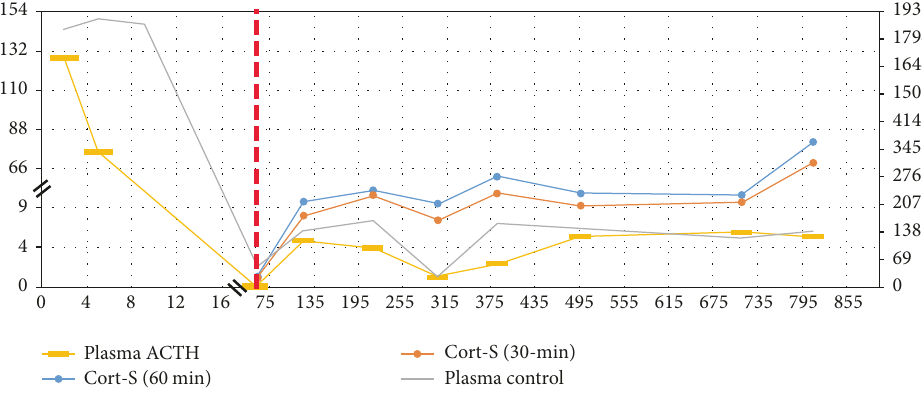
Figure 3: Cortisol and ACTH changes before and after operation. The 𝑥 -axis details the day since initial admission to our hospital. Day 19 or the red line is the resection of the esthesioneuroblastoma. The left 𝑦 -axis is the level of plasma adrenocorticotropic hormone (ACTH (pmol/L)); the right 𝑦 -axis is the level of plasma cortisol (Cort-S (nmol/L)). At his outpatient follow-up, 0.25 mg ACTH stimulation tests were done in clinic with assessment of endogenous cortisol production (plasma cortisol level measured at baseline and 30 and 60 minutes after ACTH